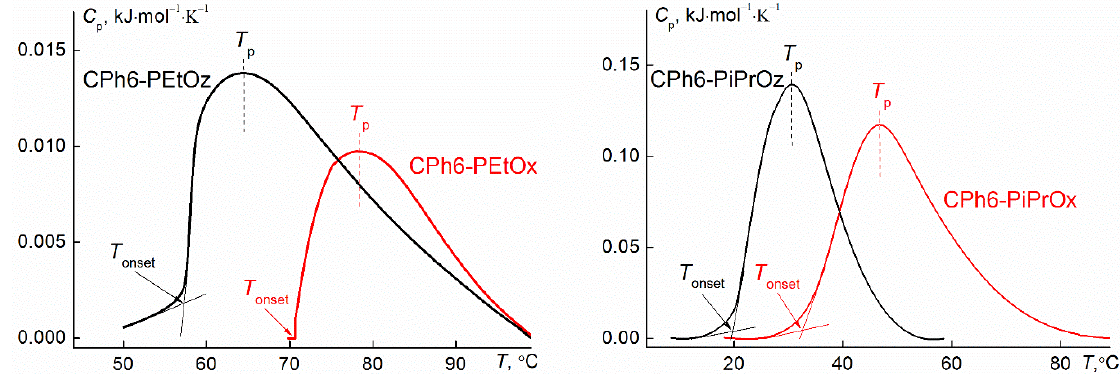
Figure 7. Microcalorimetric endotherms of CPh6-PiPrOz and CPh6-PiPrOx ( c = 0.015 g cm − 3 ) and CPh6-PEtOz and CPh6-PEtOx ( c = 0.025 g cm − 3 ) in water (rate 1.0 ◦ C/min).